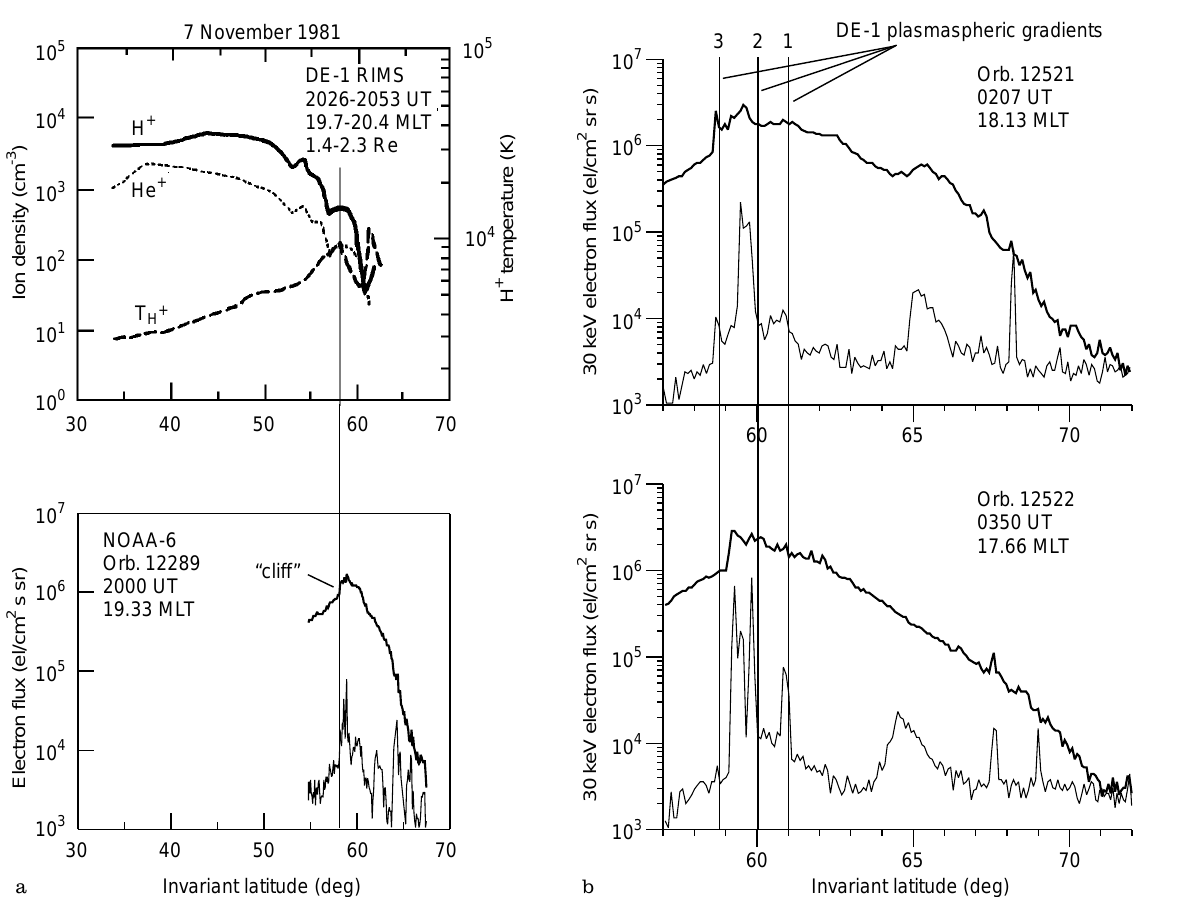
detected by the NOAA-6 satellite and gradients of the cold plasma ( marked by vertical lines ) registered by the RIMS instrument on board the